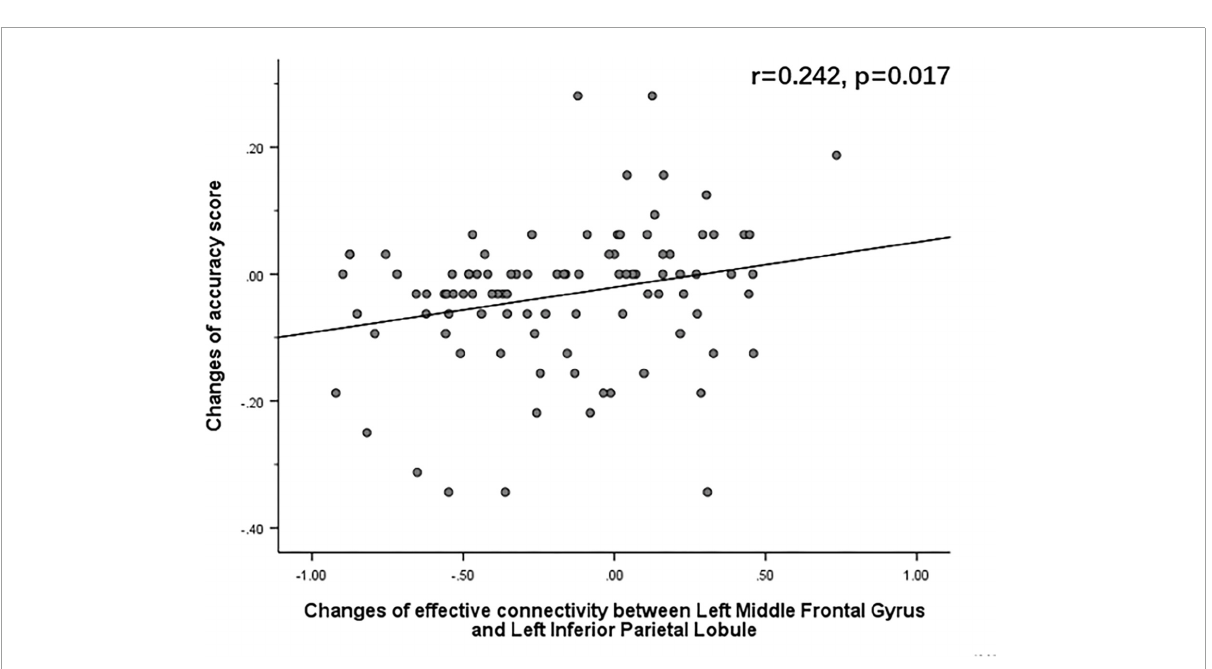
middle temporal gyrus (MT/V5) and the medial superior temporal gyrus (MST) contain directionally selective cells capable of detecting mobile stimuli (Dubner and Zeki, 1971;